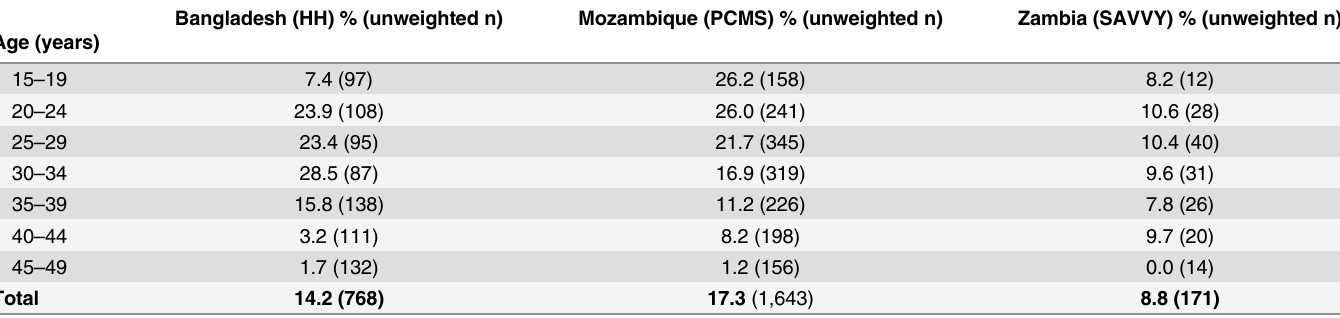
Table 5. Maternal deaths as a share of all female deaths by age group (15 – 49),